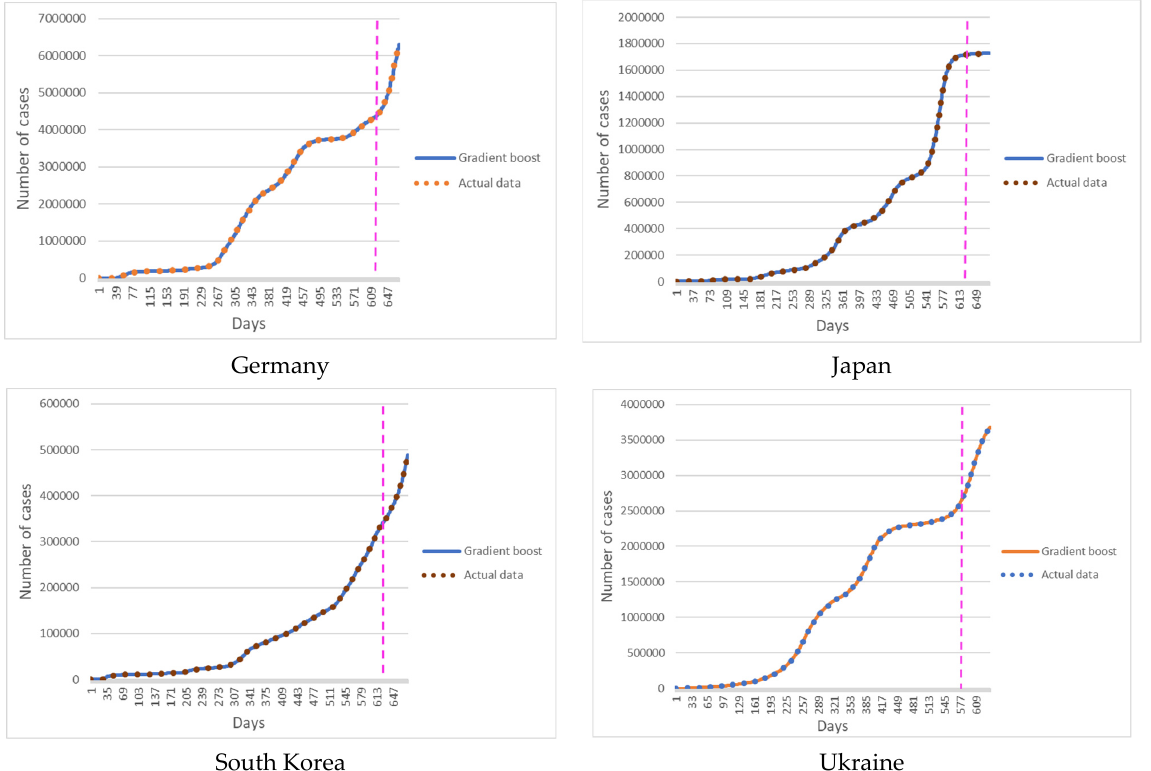
Figure 3. Forecasting of COVID-19 new cases by Gradient Boosting model.